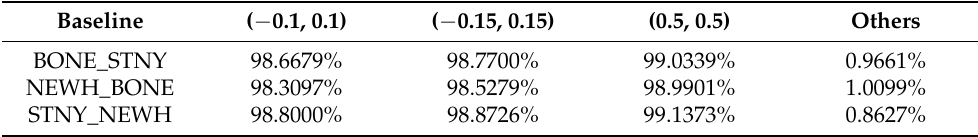
Table 3. ∇ ∆ N w statistics of the triangle closure